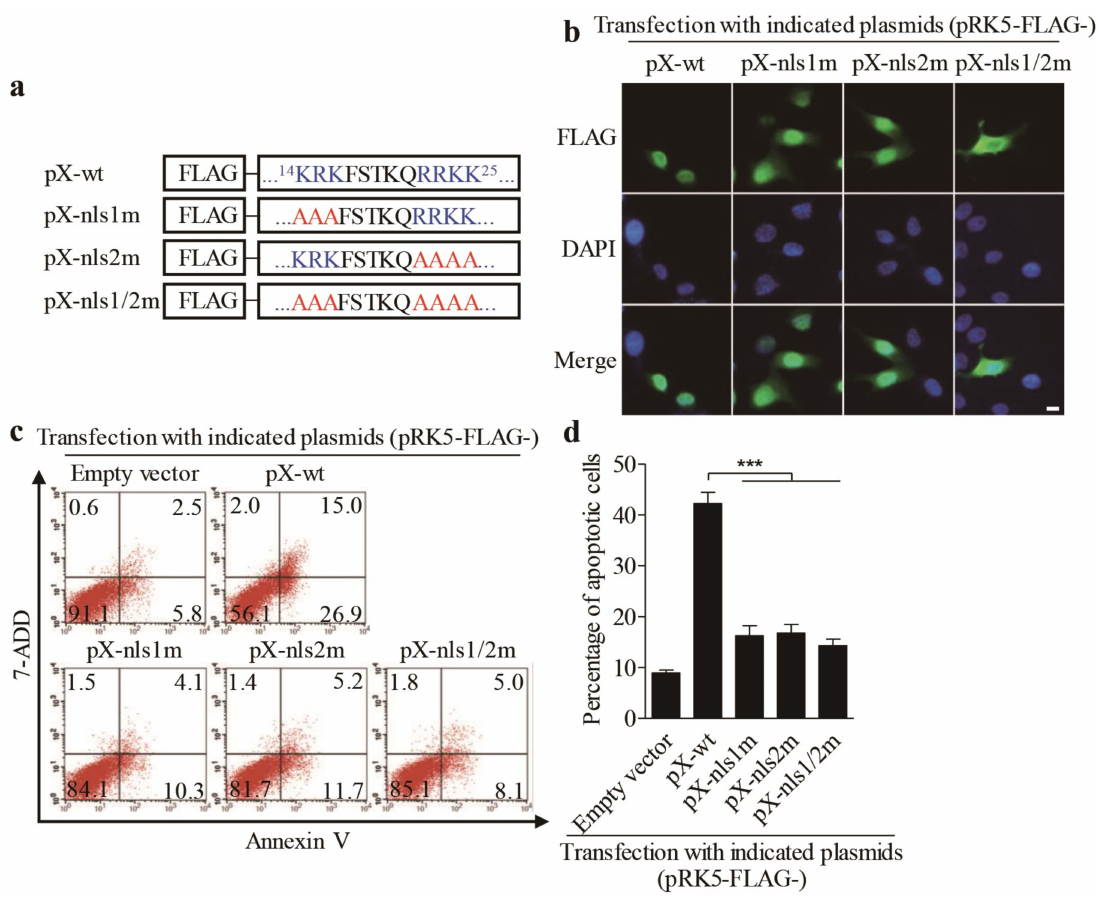
Figure 4. Mutation of nuclear localization sequences (NLS) on both sides of -FSTKQ- within the amino acids 14-25 of PX a ff ected its nuclear translocation associated with inhibition of PX-induced apoptosis. ( a ) Schematics represent the genes encoding the wild-type pX and nuclear localization sequence (NLS) mutant pX molecules (pX-wt, pX-nls1m, pX-nls2m, and pX-nls1 / 2m). ( b ) Distribution of PX or PX-nls-mutants in LMN cells. LMH cells were transfected with indicated plasmids as described in ( a ). Twenty-four hours after transfection, cells were fixed and probed with mouse anti-FLAG antibodies, followed by incubation with FITC-conjugated goat anti-mouse secondary antibodies (green). Nuclei were counterstained with DAPI (blue). LMH cells were observed with a fluorescence microscope. The scale bar represents 10 µ m. ( c , d ) Examination of apoptosis in LMH cells expressing PX or PX-NLS mutants. LMH cells were transfected with indicated plasmids as described in ( a ). Forty-eight hours after transfection, cells were harvested, stained with Annexin V-PE and 7-AAD, and analyzed by flow cytometry ( c ). The percentage of apoptotic cells in ( c ) was quantified and shown in ( d ). Results are representative of three independent experiments. Data are presented as mean ± SD, n = 3. The significance of the di ff erences between the groups was performed by one-way ANOVA (*** stands for p <